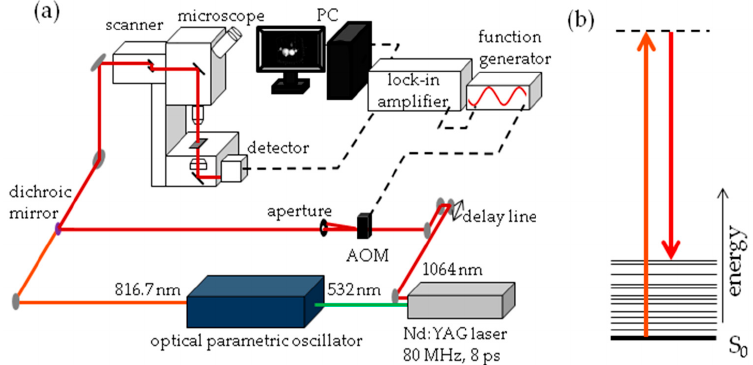
Figure 13. Stimulated Raman Scattering (SRS) imaging details ( a ) Schematic representation of SRS imaging set-up. AOM = acousto-optic modulator; ( b ) Jablonski energy diagram representation of SRS. The S 0 electronic ground state interacts with the vibrationally excited state through a virtual state. The difference in photon energy between the two lasers corresponds with the 2845 cm − 1 stretch vibration of CH 2